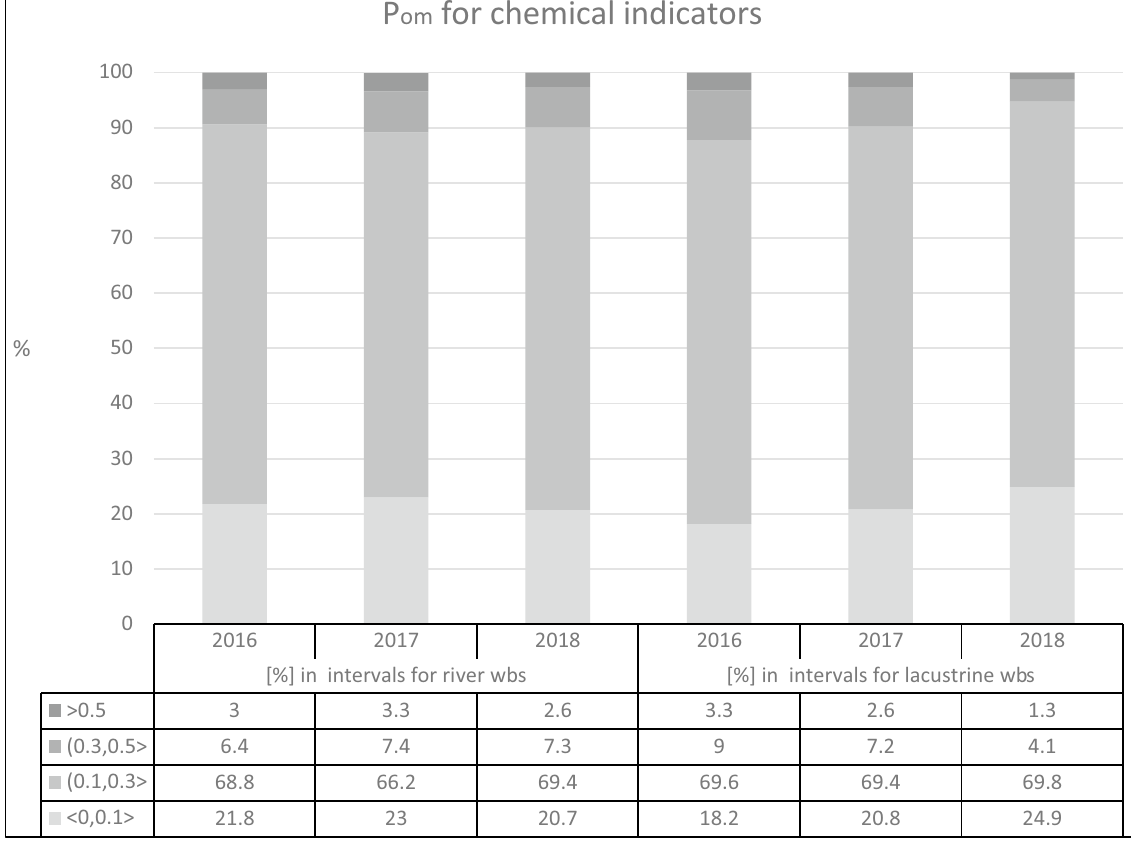
Figure 3. Probability of misclassification (P om ) of all chemical indicators (Level 3) for riverine and lacustrine water bodies in the years 2016–2018. The range of P om values is divided into four intervals: < 0, 0.1 > , (0.1, 0.3 > , (0.3, 0.5 > , and (0.5, 1 > . For each interval, the percentage of indicators with P om belonging to this interval is